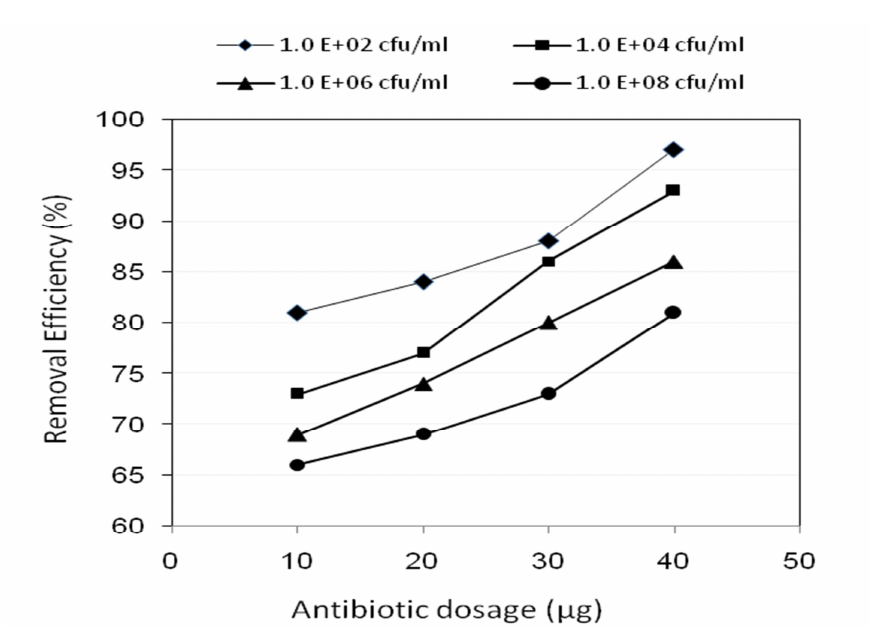
Figure 2. Removal efficiency of isolated S. aureus from hospital under ultrasonic irradiation with ampicillin (t = 100